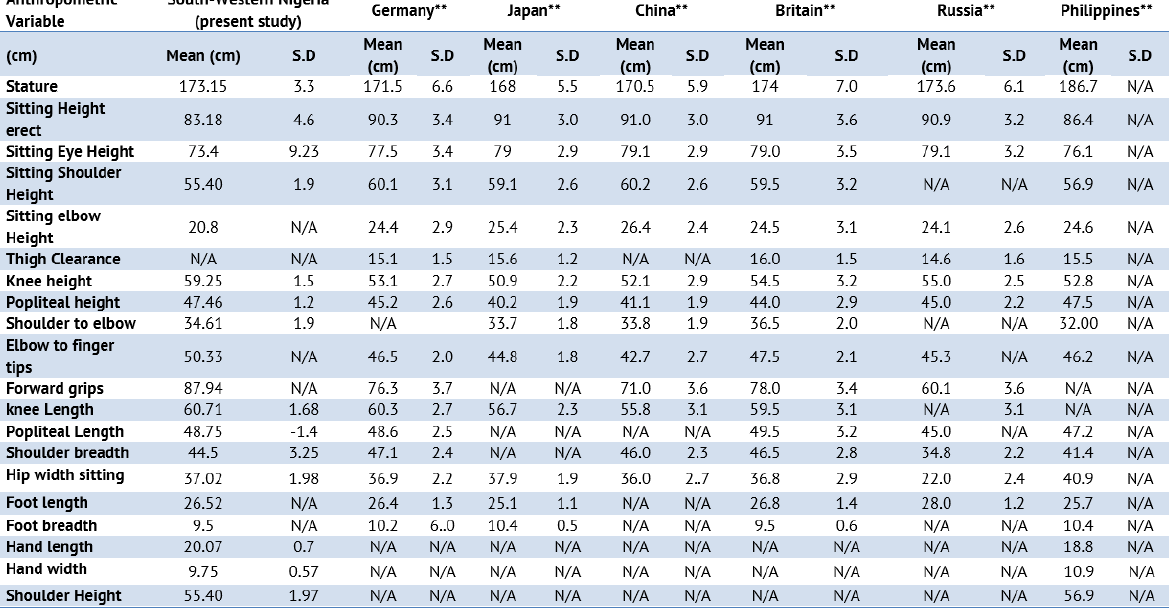
Comparison of relevant anthropometric variables of the current study and some other countries of the